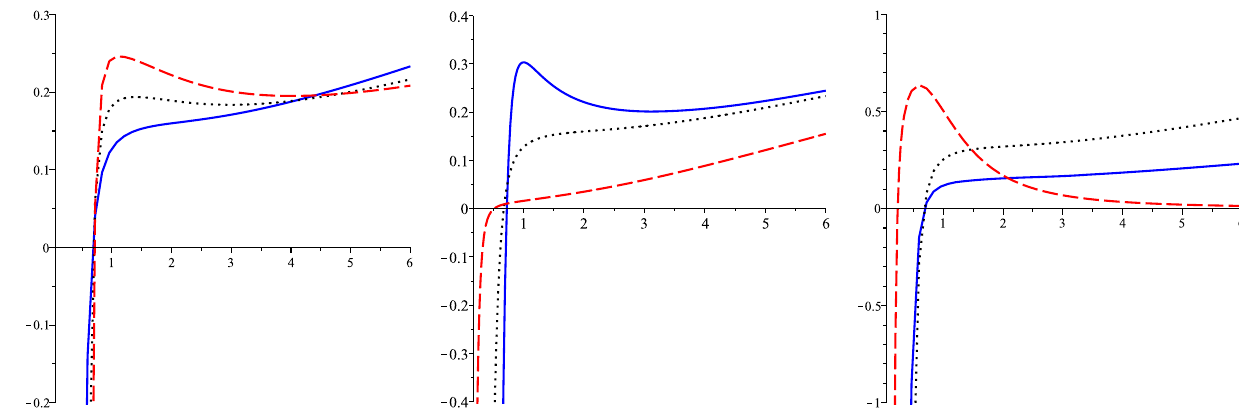
Fig. 6 T versus r + for k = 1, q = 1, P = 1 / 8 π , m = 0 . 1, c 1 = c 2 = c 3 = c 4 = 1. Left panel: for α = 1, c 0 = 1 and d = 7 (solid line), d = 8 (dotted line) and d = 9 (dashed line). Middle panel: for